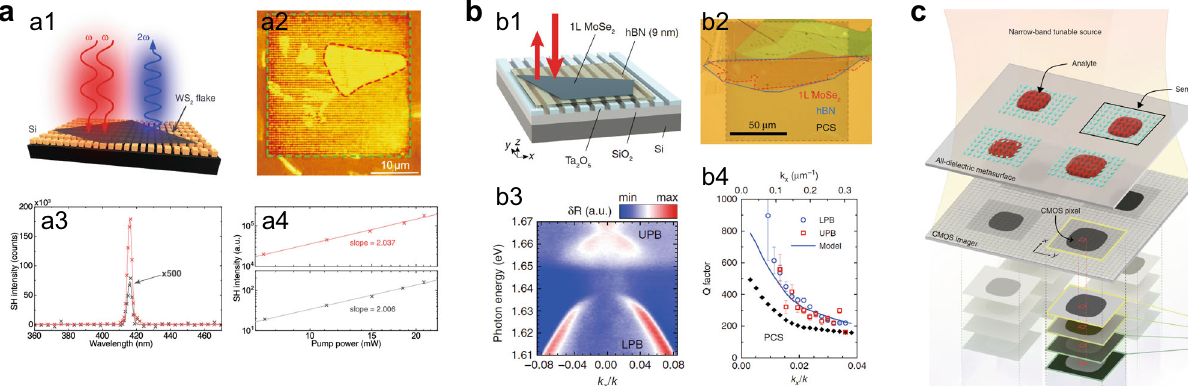
Fig. 6 Examples of the interaction between BICs and materials. a Enhanced second-harmonic generation (SHG) by hybridization of the asymmetric metasurface hosting the quasi-BIC and the monolayer WS 2 . Schematic (a1) and optical microscope image (a2) of the structure. Measured second-harmonic intensity spectra from WS 2 on the metasurface (red) and bulk Si fi lm (gray) (a3). Measured second-harmonic intensities vs. pump power for WS 2 on the metasurface (red) and bulk Si fi lm (gray) (a4). Reprinted by permission from ref. 48 , copyright 2020. b Nonlinear process in monolayer MoSe 2 on a 1D grating hosting a BIC mode. Schematic (b1) and optical microscope image (b2) of the structure. Angle-resolved re fl ectance spectra (b3) and corresponding Q factors (b4). Reprinted by permission from ref. 59 , copyright 2020. c Hyperspectral imaging-based biomolecule detection. Recorded images with a CMOS camera create a hyperspectral data cube from high-resolution spectral information of individual pixels. Reprinted by permission from ref. 62 , copyright